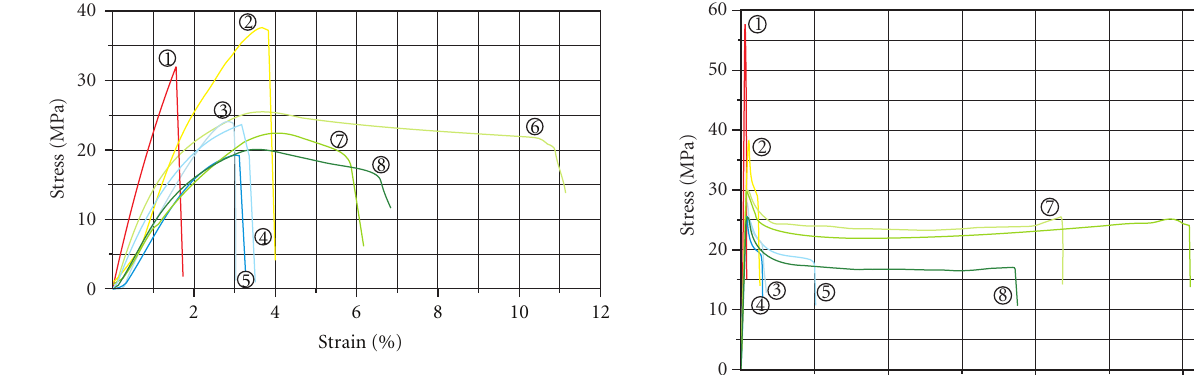
F 1: Stress-strain curves in machine direction.